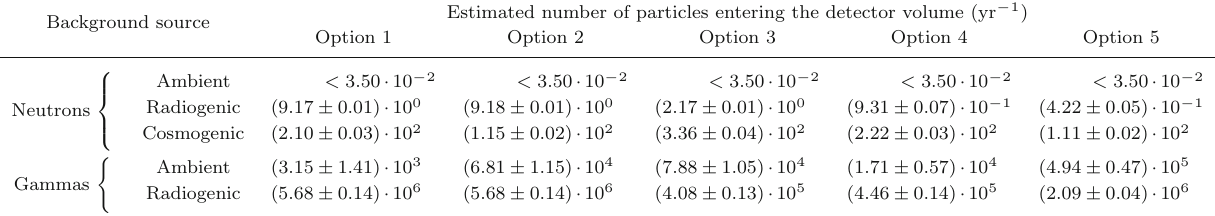
the number of events per year, in which at least one particle of the corre- sponding background source enters the detector volume. Stated values include 1 σ statistical